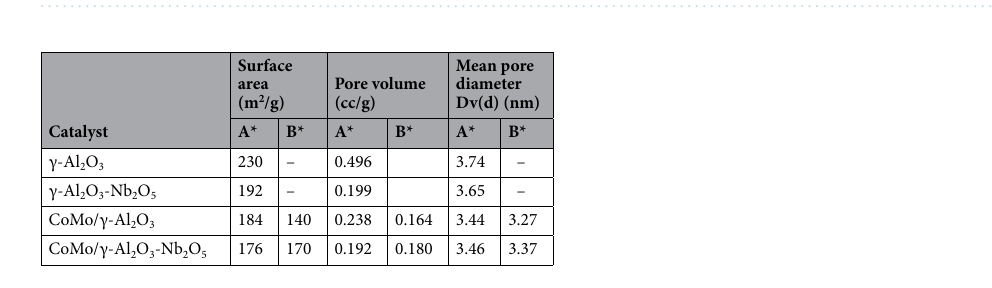
Figure 2. Pore size distribution and adsorption desorption isotherm of the CoMo/γ-Al 2 O 3 -Nb 2 O 5 catalyst before ( A ) and after ( B ) sulphidation.